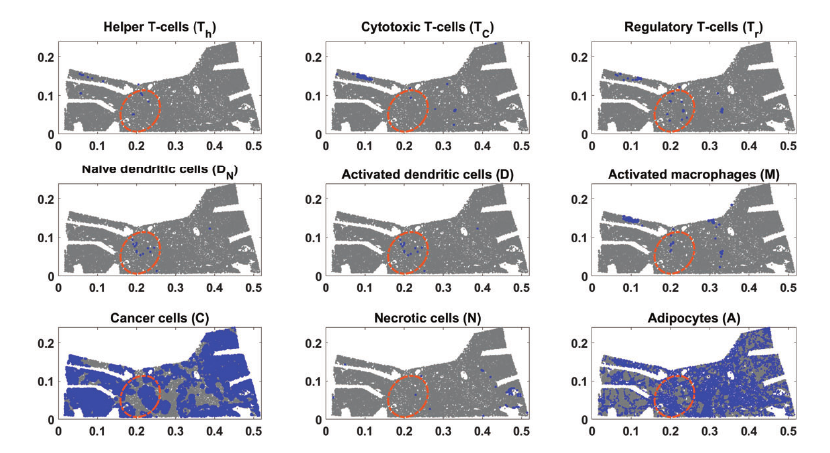
Figure 2. Nine figures showing the position of the chosen elliptical domain compared to each cell type. Blue dots represent a single cell of the corresponding cell type, and gray dots are the rest.